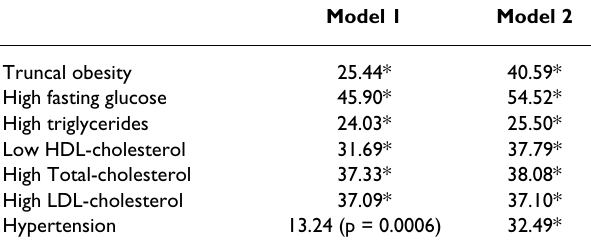
Table 3: Heritability (h2) estimates, and standard error, for cardiovascular risk factors treated as dichotomized traits, unadjusted (Model 1) or adjusted for age, sex, age2, and age × sex interaction (Model